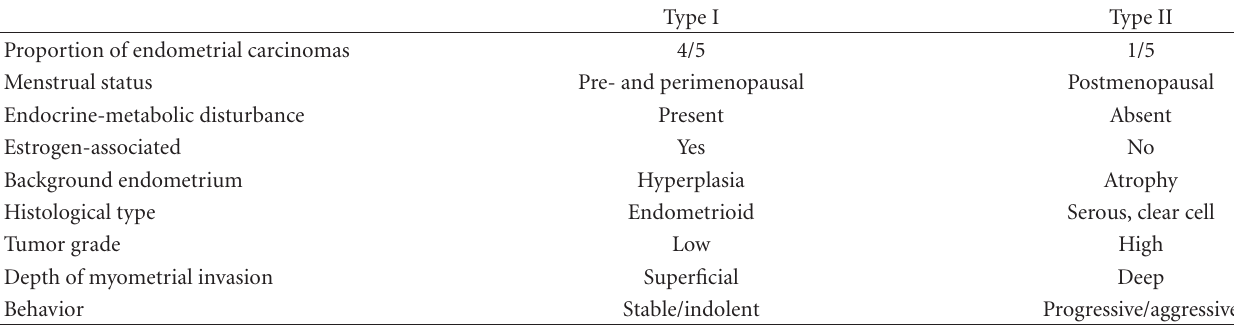
Table 1: Clinical and pathological characteristics of type I and type II endometrial carcinoma [1, 2,